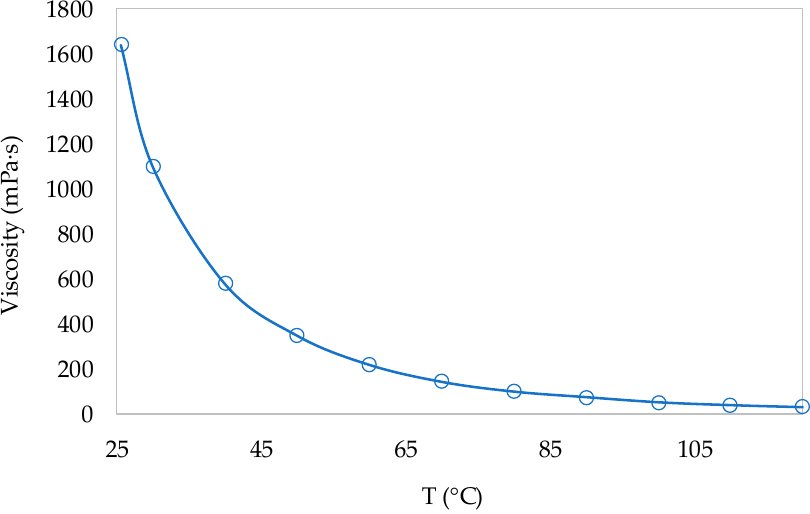
Figure 2. Viscosity measurements of [Emim][HSO 4 ] versus temperature.